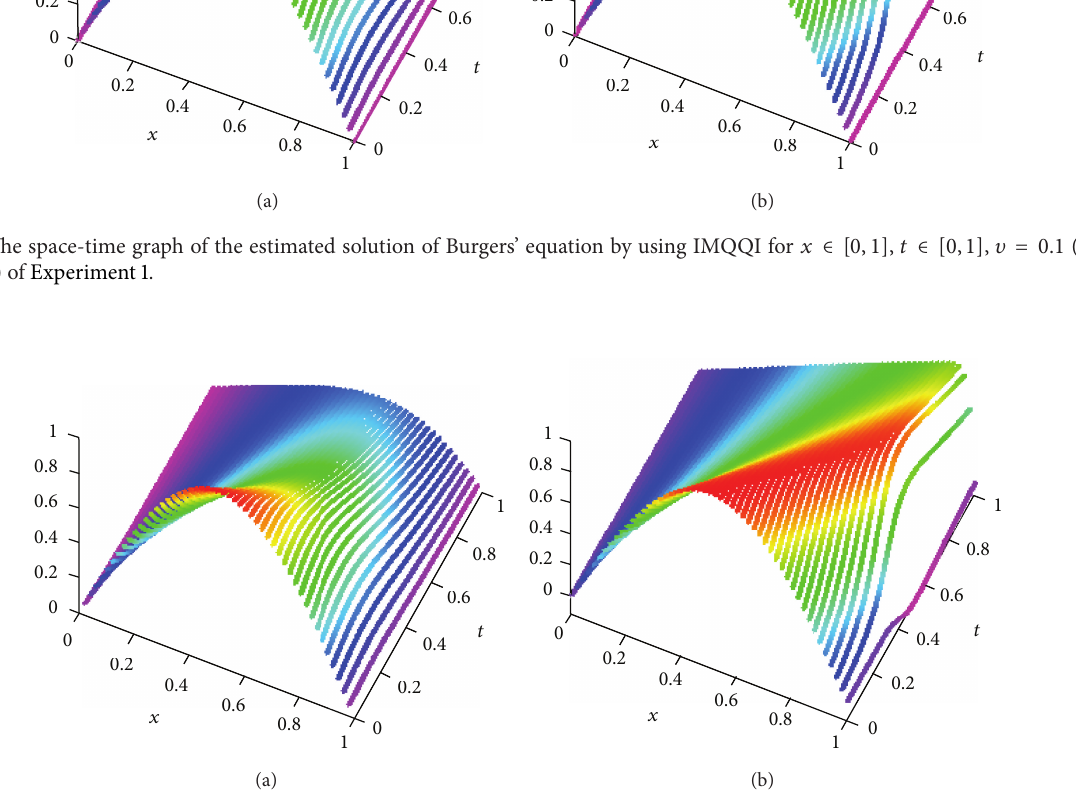
Figure 2: The space-time graph of the estimated solution of Burgers’ equation by using DMQQI for 𝑥 ∈ [0,1] , 𝑡 ∈ [0, 1] , 𝜐 = 0.1 (a), and 𝜐 = 0.01 (b) of Experiment